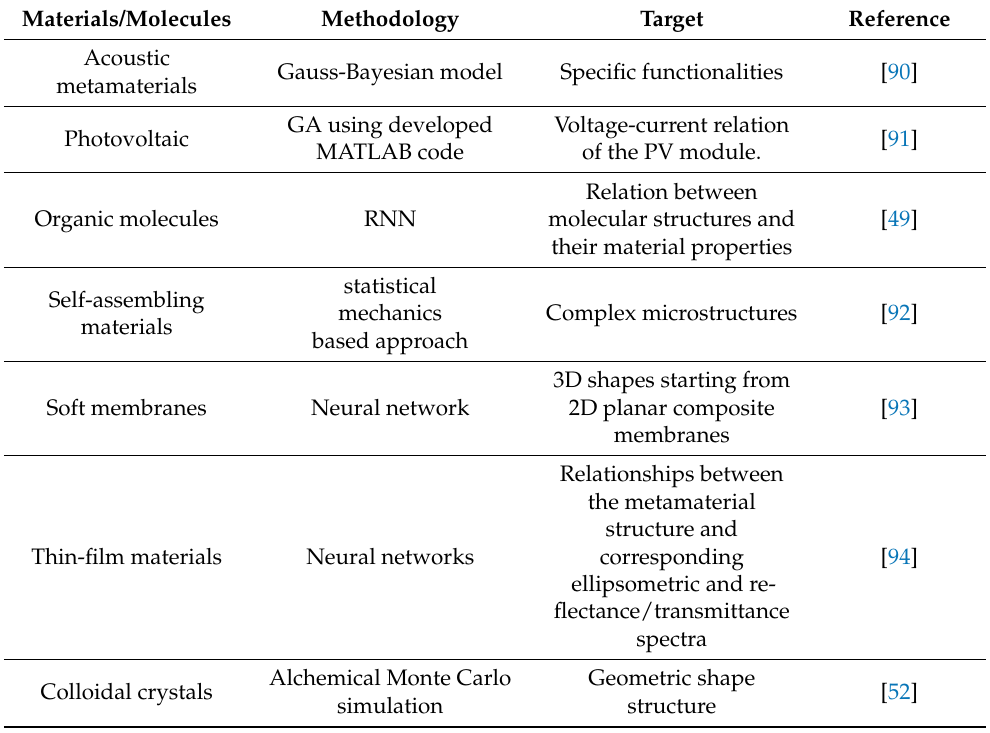
Table 1. Other advanced materials inverse design by machine